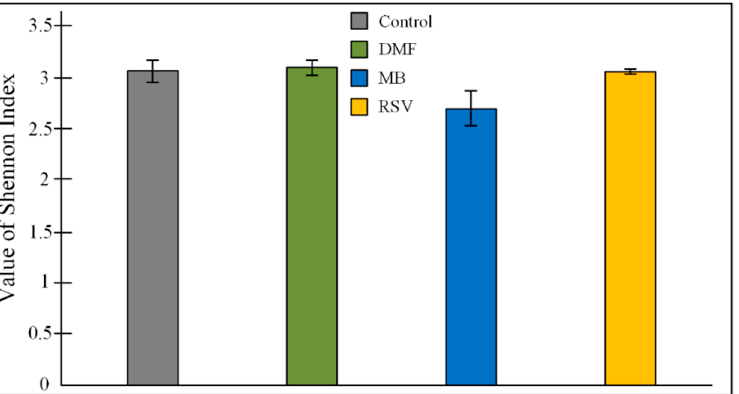
Figure 10. Value of Shannon index ( H ) of alfa-diversity. The results are expressed as means ± SEM. Control n = 8, DMF = 6, MB = 6, RSV = 6.